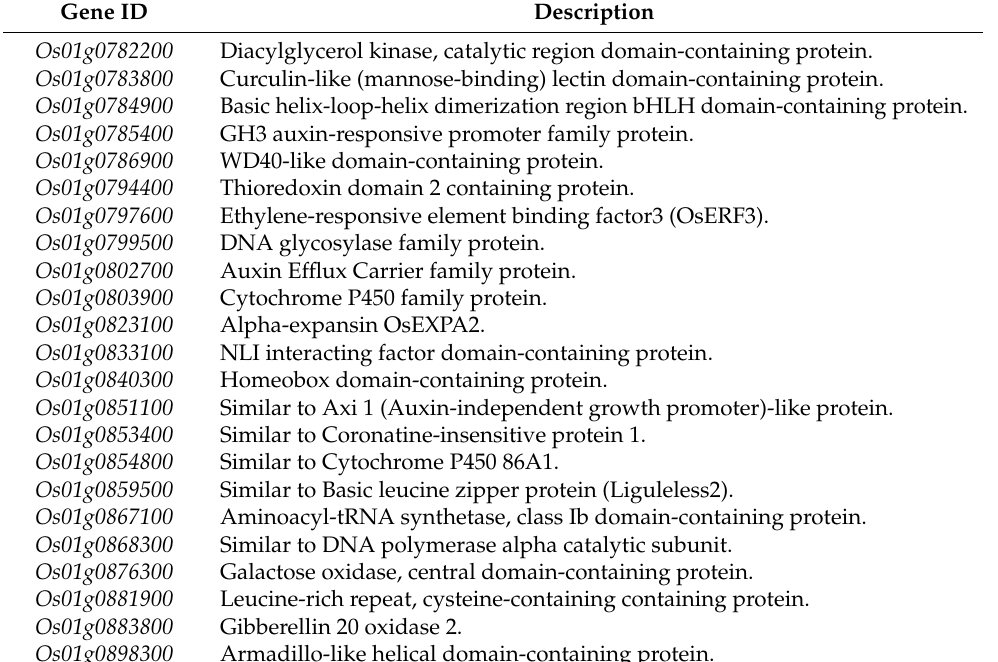
Table 2. Twenty-three related genes were screened from the target interval RM12285-RM212 on chromosome